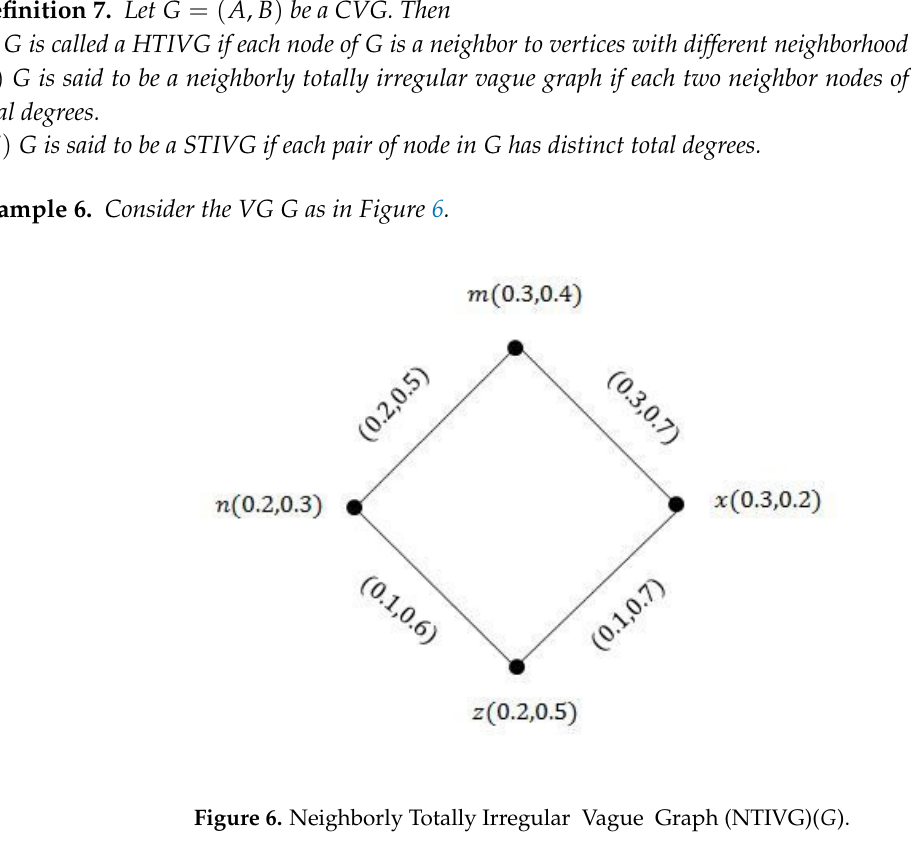
Figure 6. Neighborly Totally Irregular Vague Graph (NTIVG)( G